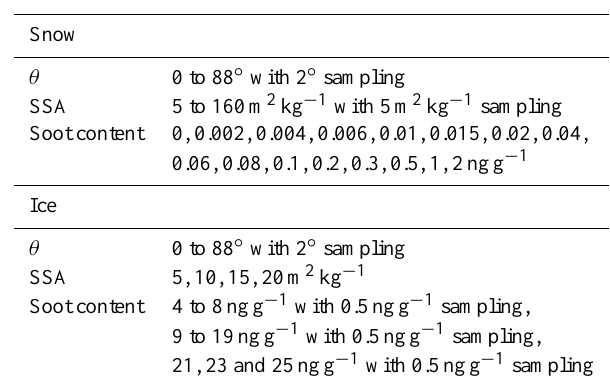
Table 3. Description of the DISORT Look-Up-Tables used to in- fer SSA and soot content from spectral albedo values. The SSA range chosen for snow is the maximum range found in the literature (Domine et al., 2007). The soot content is based on the one de- scribed in Gardner and Sharp (2010). The parameters for ice were chosen so that the range of spectral albedo corresponds to the mea- sured ice albedo range found in the literature (Gardner and Sharp, 2010).